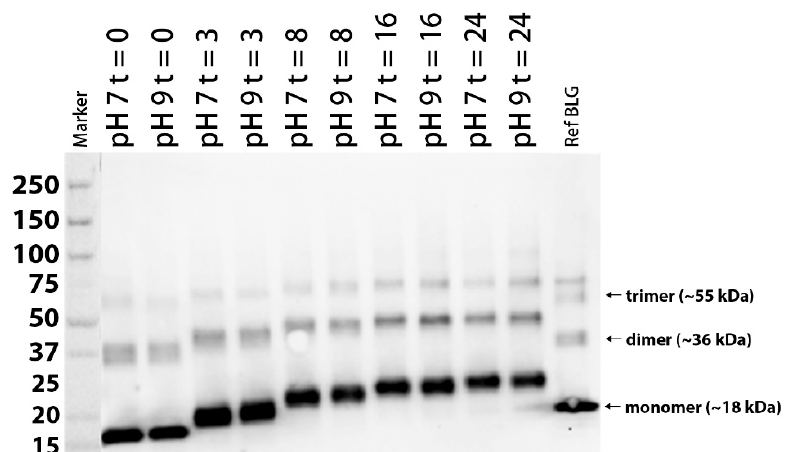
Figure 1. Western blot of reference BLG (Davisco JE 003-6-922) and lactosylated BLGWT (lacBLG) after 0, 3, 8, 16 and 24 h incubation at pH 7 and 9 and 65 °C. Protein ladder is expressed in kDa. Equal formation of dimers and trimers of BLG was evident during the time course. Comparable to monomers, lactosylation can be observed amongst dimers and trimers.